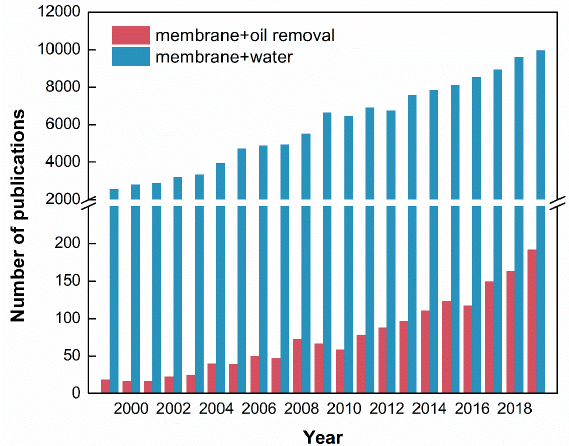
Figure 1. The total number of publications associated with membranes in the literature during 1999 to 2019.